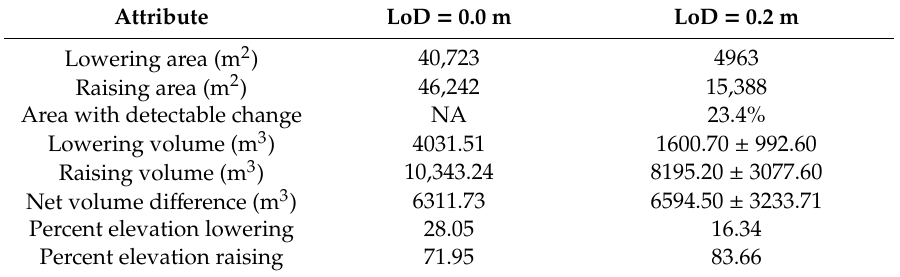
Table 7. Analysis of GCD values in the Rodas system with different Limits of Detection (LoD). Attribute LoD = 0.0 m